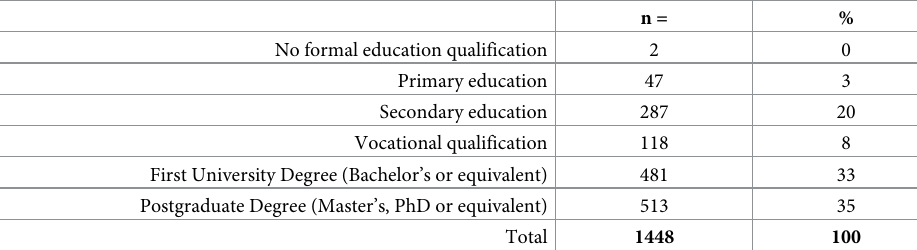
Table 3. Comparison of educational attainment of respondents across all event